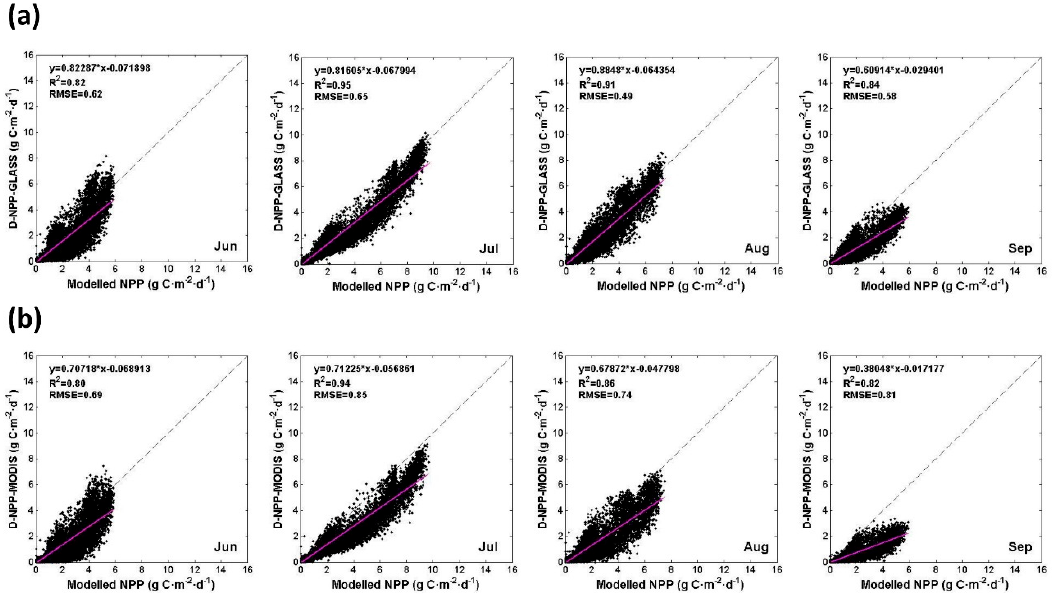
Figure 14. Cross validation of estimated NPP against high resolution NPP: ( a ) Comparison of D_NPP_GLASS and modelled GPP; ( b ) Comparison of D_NPP_MODIS and modelled GPP. D_NPP_MODIS means the NPP from downscaled FPAR/LAI based on MODIS data by using MusyQ GPP/NPP algorithm. D_NPP_GLASS means the GPP from downscaled FPAR/LAI based on GLASS data by using MusyQ GPP/NPP algorithm. Modelled NPP is the NPP from retrieved FPAR/LAI by using MusyQ GPP/NPP algorithm.